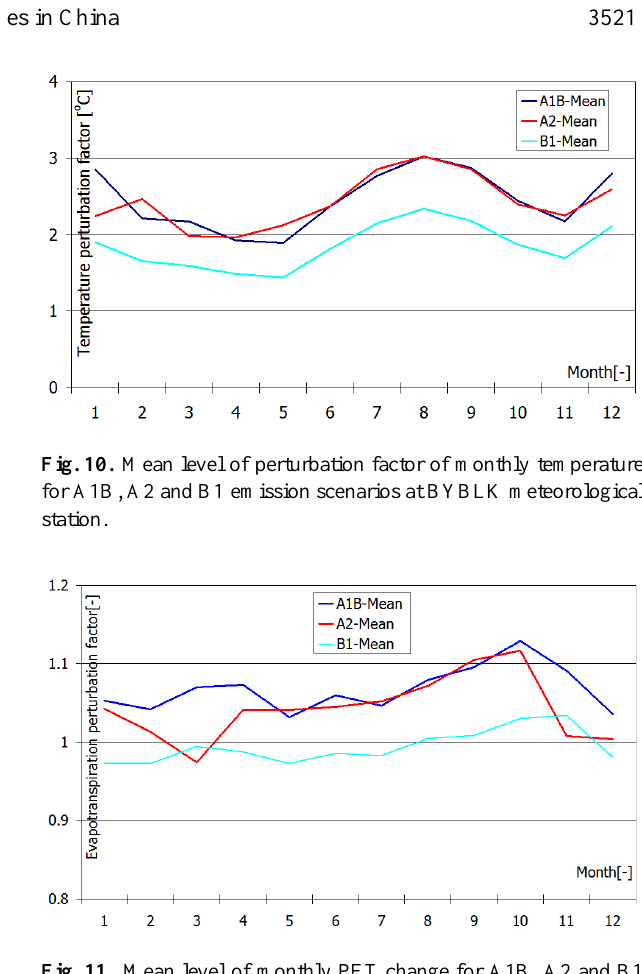
Fig. 11. Mean level of monthly PET change for A1B, A2 and B1 emission scenarios at BYBLK meteorological